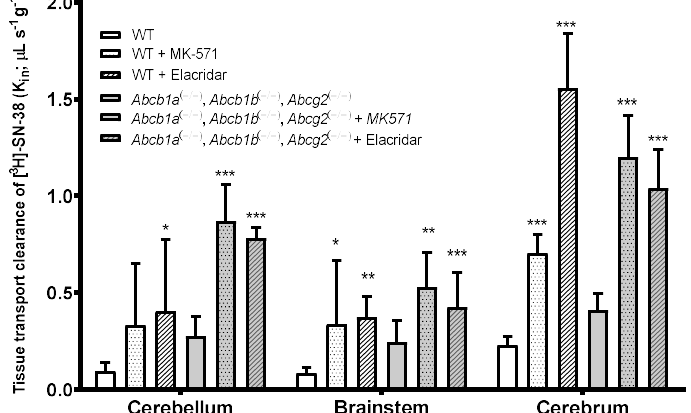
Figure 5. Brain transport (Kin; µ L s − 1 g − 1 ) of [ 3 H]-SN-38 with and without co-perfusion of the dual P-gp / Bcrp inhibitor Elacridar (10 µ M) or Mrp inhibitor MK-571 (100 µ M), measured by in situ brain perfusion in wild-type (WT) and triple knock-out (TKO) (Abcb1a( − / − ), Abcb1b( − / − ), Abcg2( − / − )) mice. Results are expressed as mean ± S.D. ( n = 4–6 mice per group). One-way ANOVA, * p < 0.05; ** p < 0.01; *** p < 0.001 vs. control group.